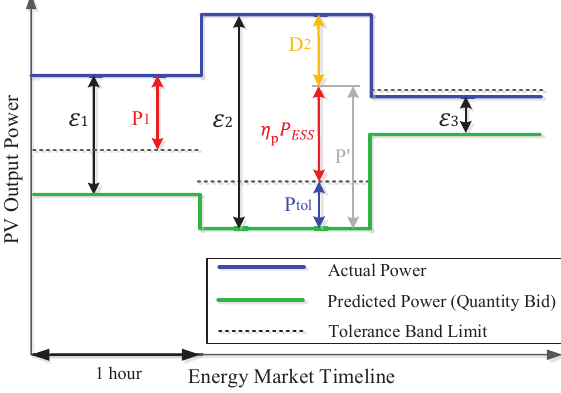
Figure 6. Estimation of three different positive deviations for charging the ESS.